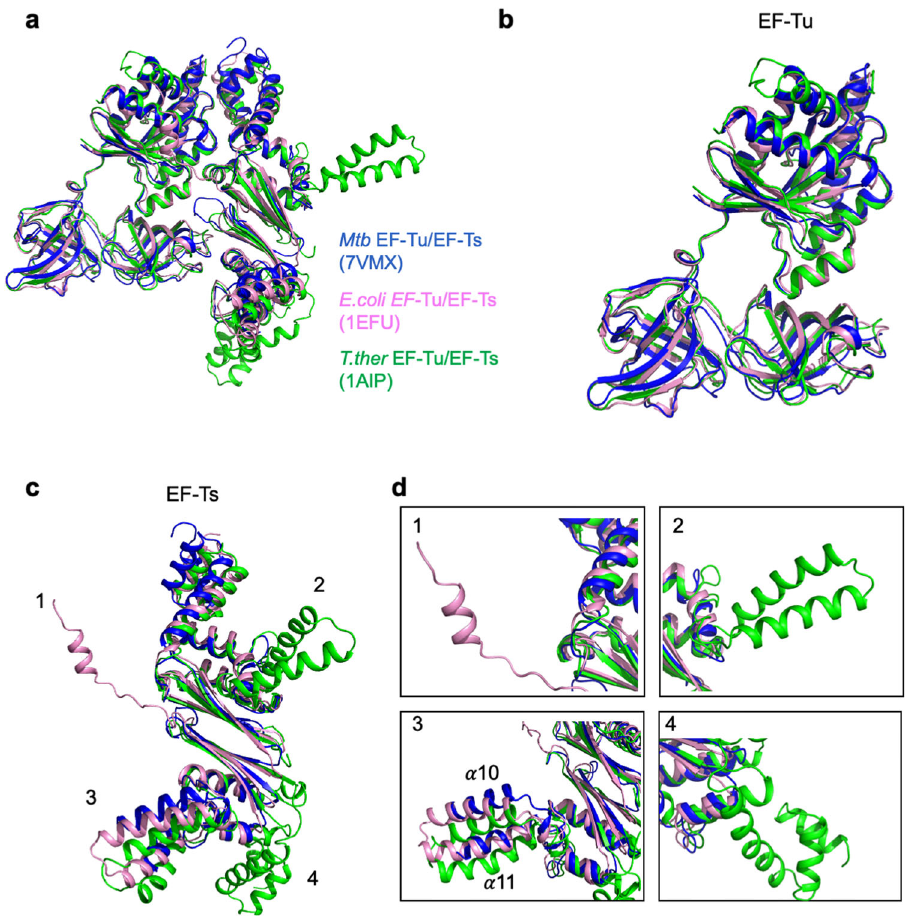
Fig. 3 EF-Ts exhibits a diverse binding conformation among different species. a Superimposition of EF-Tu (cid:129) EF-Ts complex structures among Mtb (marine, PDB: 7VMX), E. coli (light pink, PDB: 1EFU), and T. thermophilus (green, PDB: 1AIP). The RMSD values between Mtb and E. coli or T. thermophilus were 1.214 Å or 1.309 Å, respectively. b Superimposition of EF-Tu structures among Mtb, E. coli , and T. thermophilus . c Superimposition of EF-Ts structures among Mtb, E. coli , and T. thermophilus . The numbers denoted signi fi cant differences among the three structures. d The detailed difference of EF-Ts structures among three species, according to ( c ). ‘ 1 ’ , the extra helix of E. coli EF-Ts for binding with EF-Tu Domain I. ‘ 2 ’ and ‘ 4 ’ , the helices in the T. thermophilus EF-Ts, absent in Mtb and E. coli , which were not involved in binding with EF-Tu. ‘ 3 ’ , the α 10 and α 11 helices that shifted about 4.7 Å or 6.0 Å within three species, When superimposing the EF-Tu molecules in the EF-Tu (cid:129) GDP and EF-Tu (cid:129) EF-Ts structures, it showed similar features of overall folds with an RMSD value of 0.711 Å (Fig. 4d). A signi fi cant